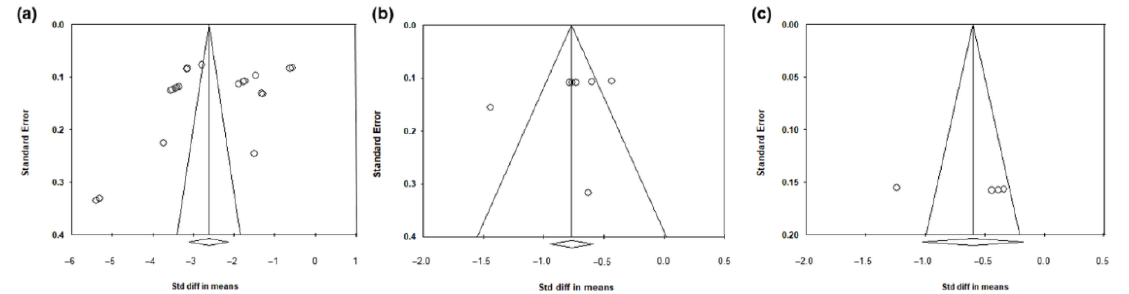
Figure 5. Funnel plots evaluating the publication biases regarding the IOP-lowering impacts of ( a ) LBN 0.024%; ( b ) the comparison between LBN 0.024% and timolol maleate 0.5%; and ( c ) the comparison between LBN 0.024% and latanoprost 0.005%. Circles represented studies.